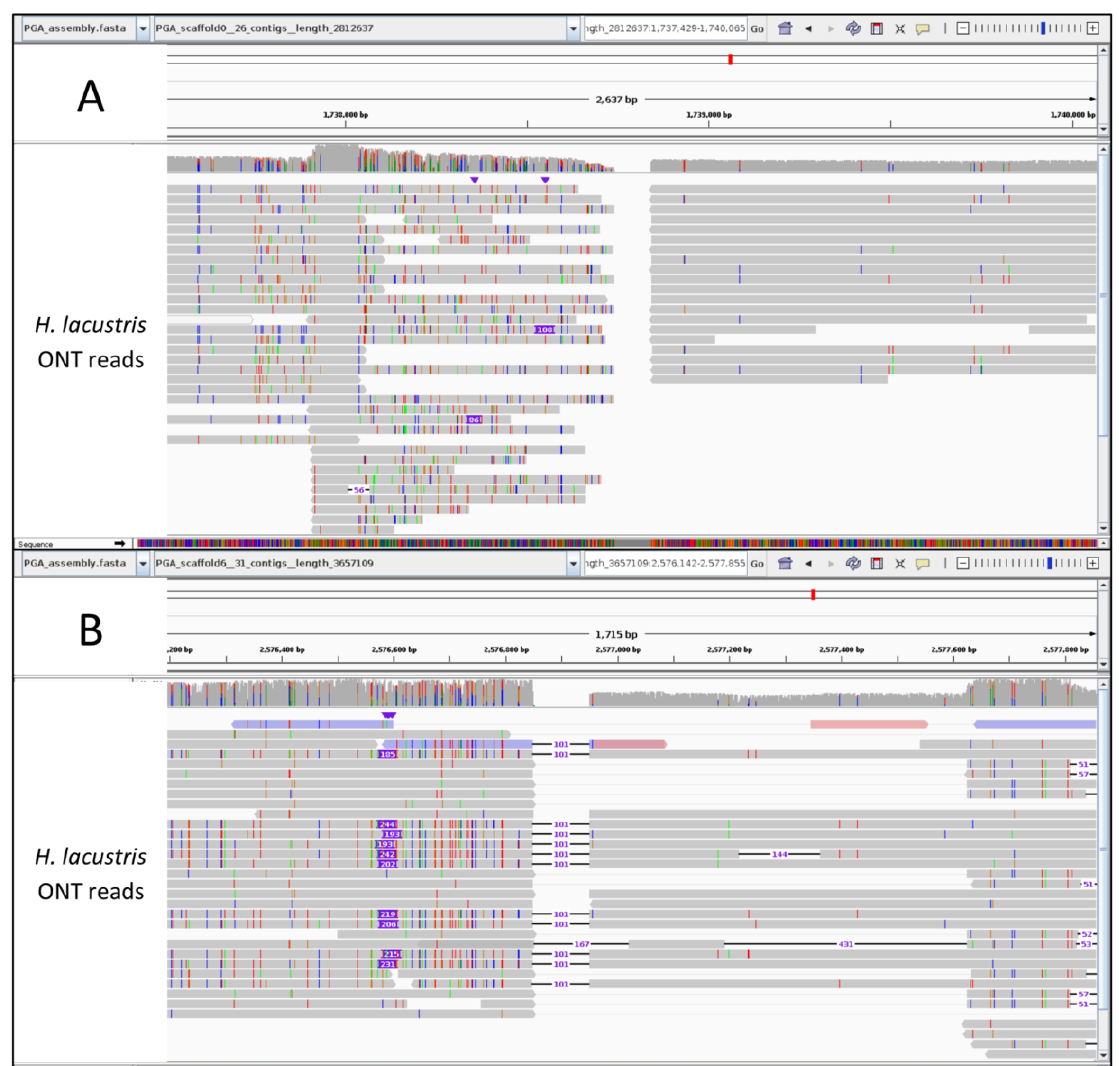
Figure 2. Integrative Genome Browser of two junction regions identified as potential errors by optical maps. ONT data mapped to the Hi-C-scaffolded H. lacustris genome show either ( A ) no reads spanning the contig junction or ( B ) reads spanning the junction but highlighting the incorrect gap size.